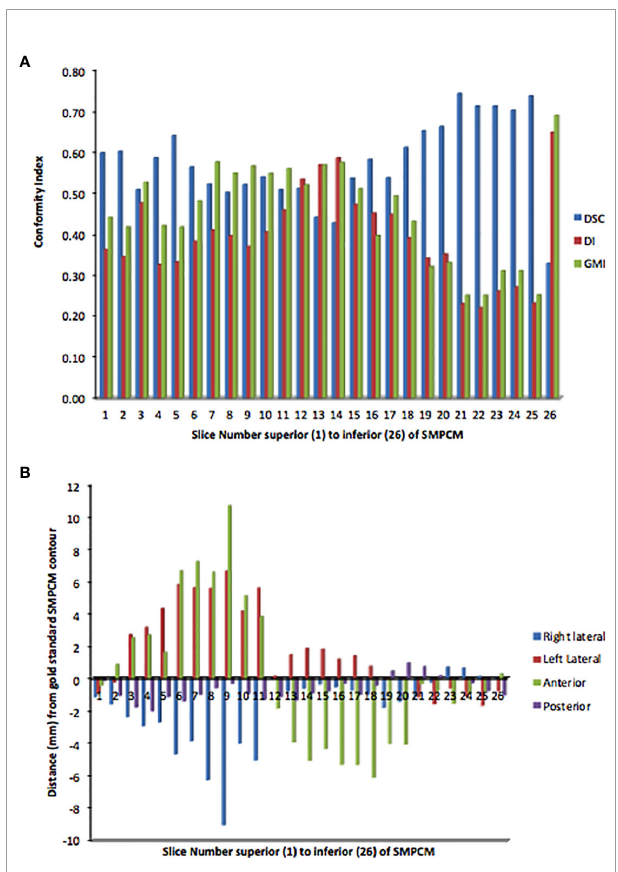
FIGURE 3 | Slice-by-slice conformity (A) and positional (B) analysis of clinicians ’ superior and middle constrictor muscle (PI-SMPCM) contours DI, discordance index; DSC, DICE similarity co-ef fi cient; GMI, geographical miss